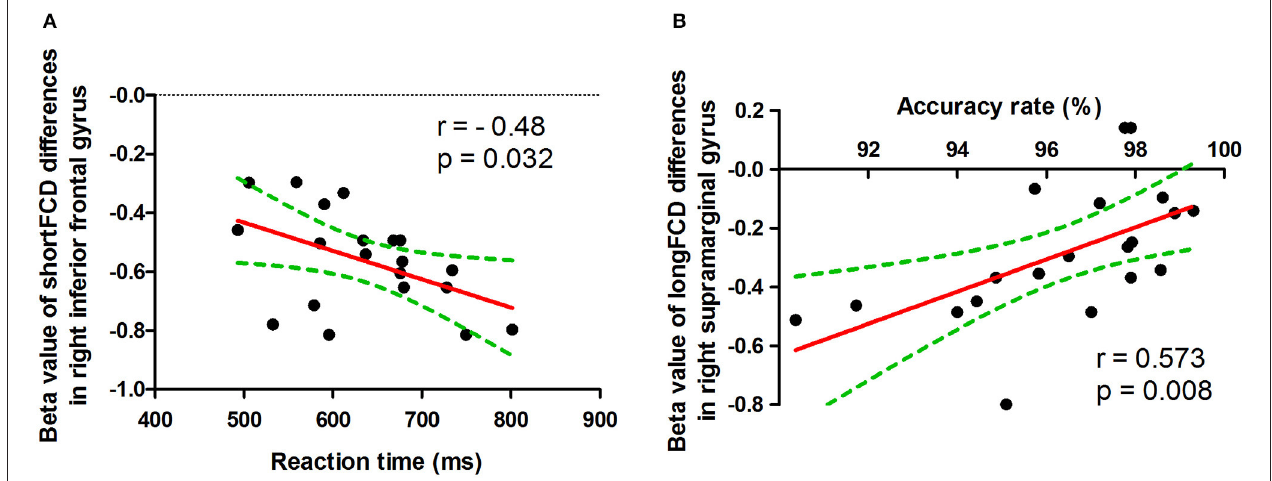
FIGURE 8 | Pearson correlation between beta value of FCD differences in brain areas and ANT. ShortFCD, short-range functional connectivity density; longFCD, long-range functional connectivity